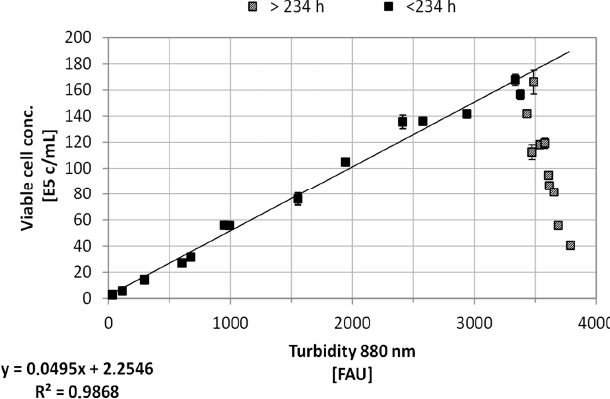
Figure 8. Correlation between offline viable cell concentration (E5 cells/mL) determination and online turbidity measurements (880 nm, FAU) prior to and after 234 h bioreactor cultivation. Error bars represent the double determination of cell concentration, as well as the deviation of the probe (0.75%). The coefficient of determination for this linear relation is >0.98 for t < 234 h.